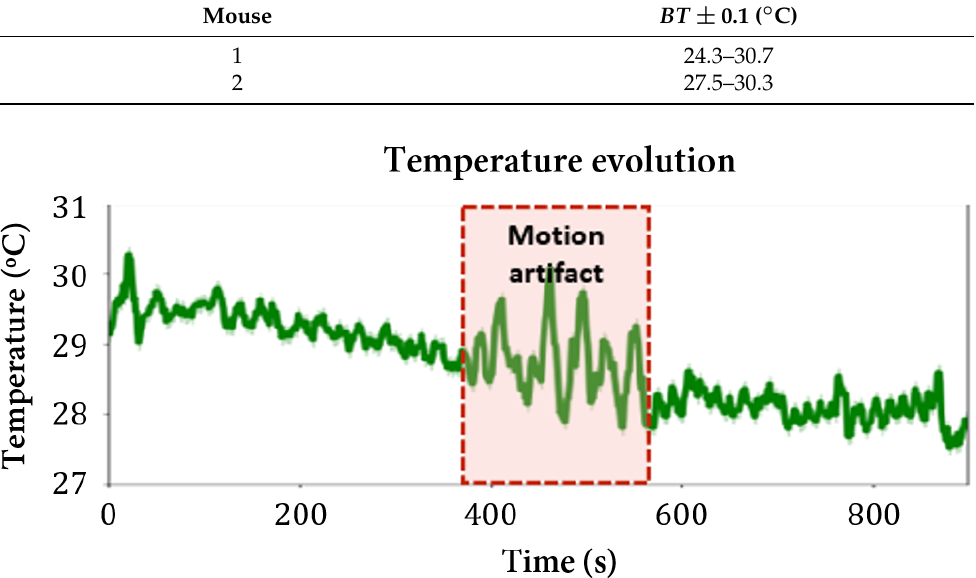
Table 4. Body temperature (BT) ranges for the two tested mice.